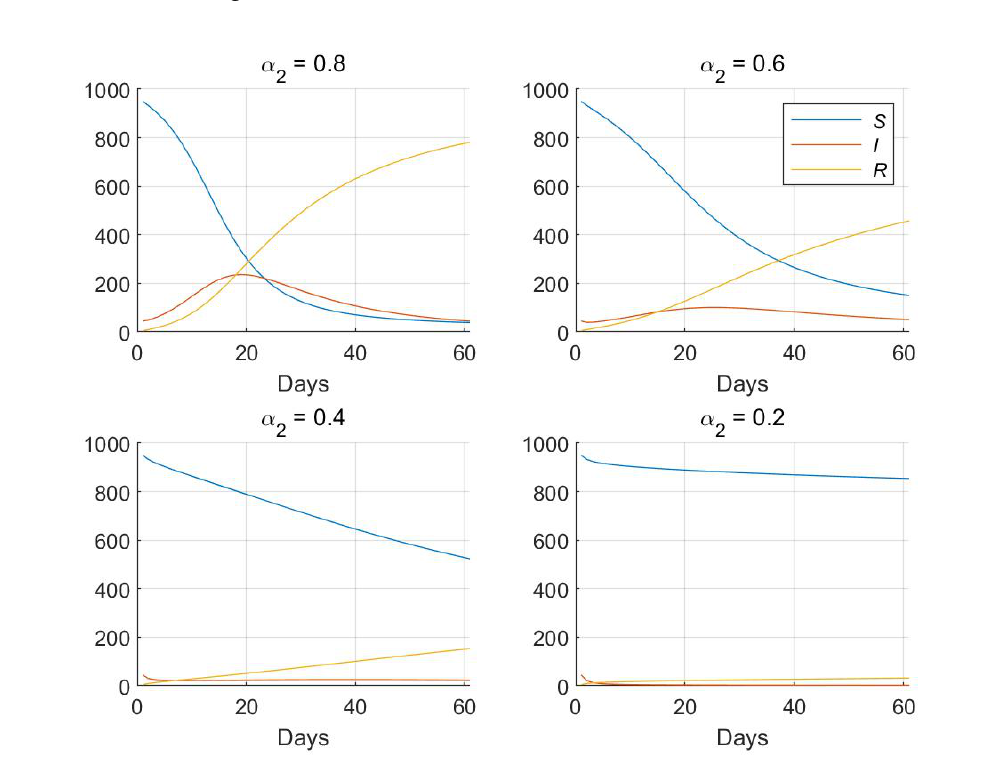
Figure 2. Simulation results for various α 2 and α 1 = α 3 =